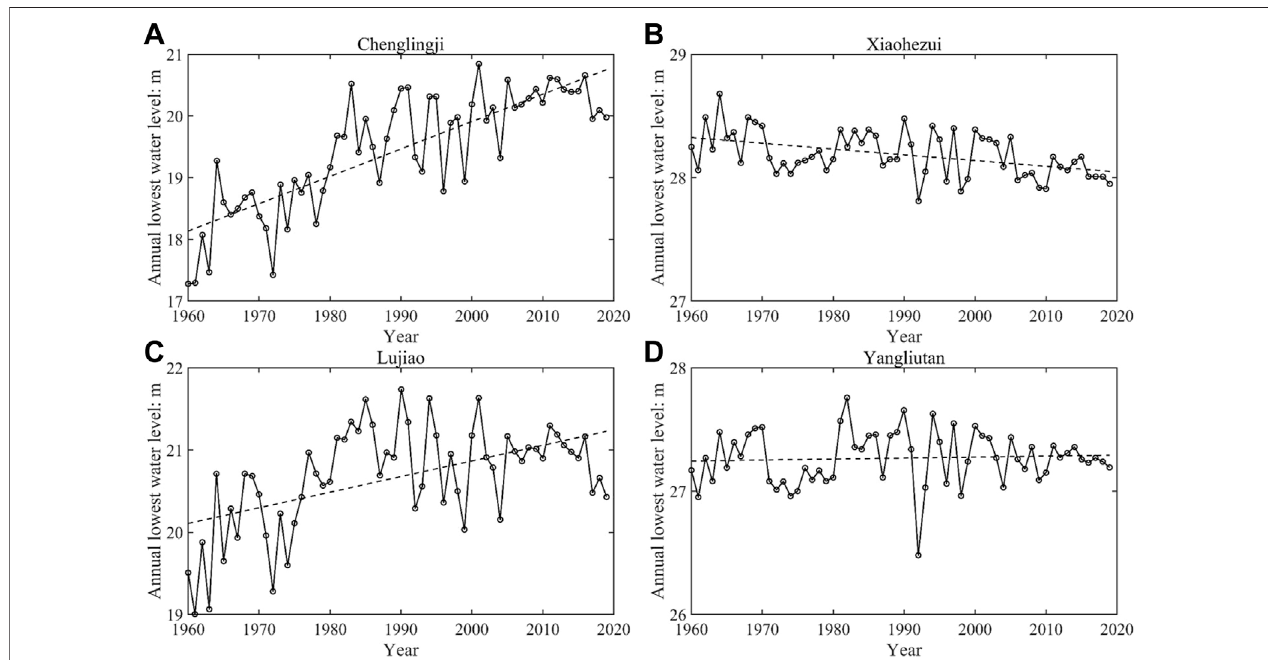
FIGURE 10 | Process diagram of annual lowest water level of each station in the Dongting Lake area (A) Chenglingji; (B) Xiaohezui; (C) Lujiao; (D) Yangliutan.